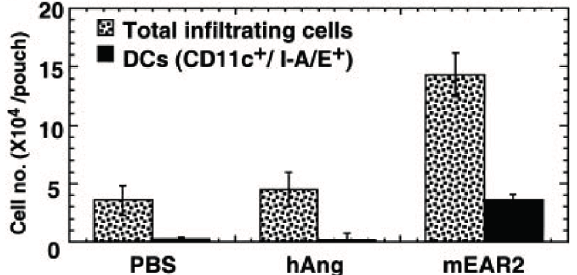
Figure 5. Recombinant mEar2 promotes leukocyte recruitment in vivo . Recombinant mEar 2 (but not human angiogenin) elicited recruitment of CD11c + dendritic cells as a fraction of total leukocytes into airpouches. Reprinted from [68] with permission from American Society of